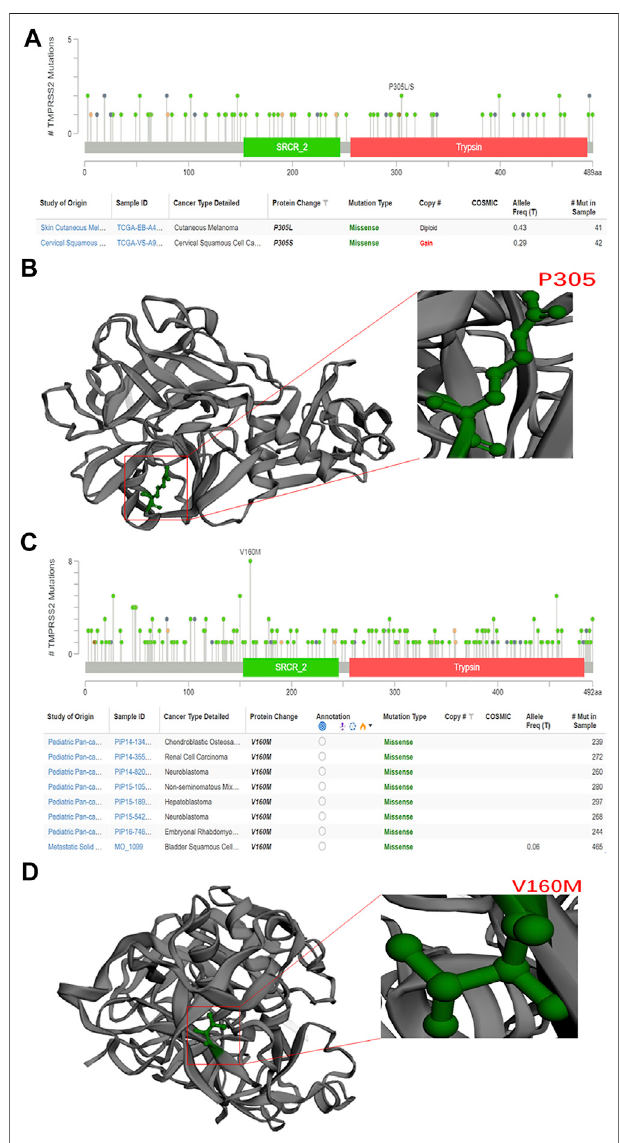
FIGURE2| MethylationlevelofTMPRSS2inpan-cancer. (A) TMPRSS2 promoter DNA methylation probe. (B) Three tumors with high expression of TMPRSS2 showed reduced levels of TMPRSS2 DNA methylation, including colon adenocarcinoma (COAD), prostate adenocarcinoma (PRAD), and rectal adenocarcinoma (READ), ** p < 0.01. (C) Tumors with downregulated TMPRSS2 expression, including breast invasive carcinoma (BRCA), esophageal carcinoma (ESCA), head and neck squamous cell carcinoma (HNSC), kidney renal clear cell carcinoma (KIRC), kidney renal papillary cell carcinoma (KIRP), lung squamous cell carcinoma (LUSC), sarcoma (SARC), skin cutaneous melanoma (SKCM), and thyroid carcinoma (THCA), exhibit increased levels of DNA methylation. ** p <